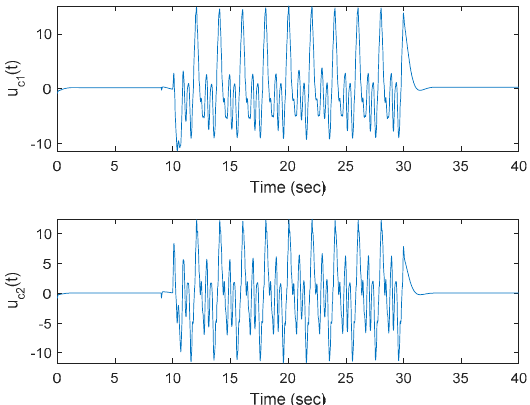
Figure 6. ( a ) Time responses of the proposed method and ( b ) errors of output